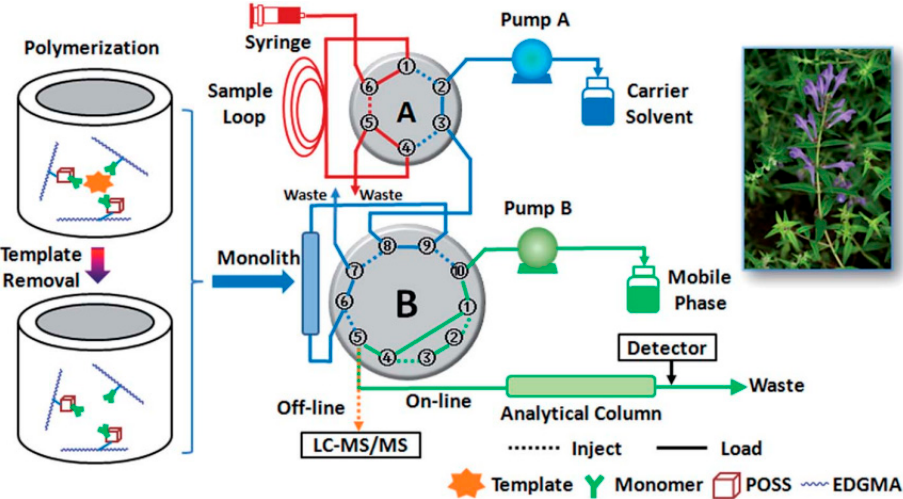
Figure 2. Scheme of the preparation and application of in-tube SPME-HPLC [58].